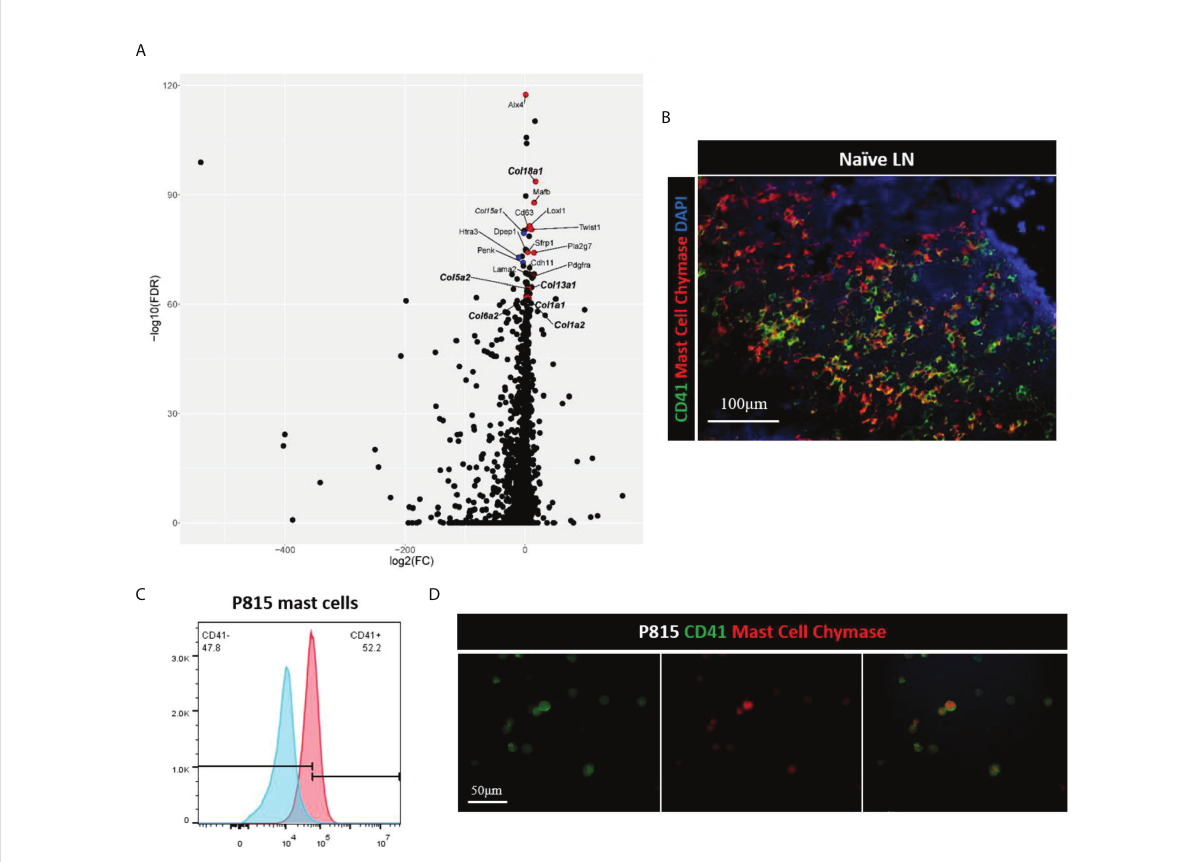
FIGURE 5 (A) Volcano plot of differential expression analysis of CD41 + cells vs. CD41 - cells, derived from single cell RNA-seq of naïve mouse lymph nodes. Stromal- and mast cell-associated genes are highlighted based on adjusted p-value, with the topmost gene, Alx4 , having an adjusted p-value of 3.5 x 10 -118 , and the lowest labeled gene, Col1a2 , having an adjusted p-value of 2.8 x 10 -62 out of the 3,064 genes that had an adjusted p-value of < 0.05. Red dots are genes that are expressed more highly in CD41 + cells than CD41 - cells, and blue dots are those genes which are expressed less in CD41 + cells than CD41 - cells. (B) IF images of mouse naïve LN cells showed that mast cells (red) expressed CD41 (green). DAPI (blue). (C, D) Flow cytometry analysis and IF images showed mast cell line P815 (red) expressed CD41